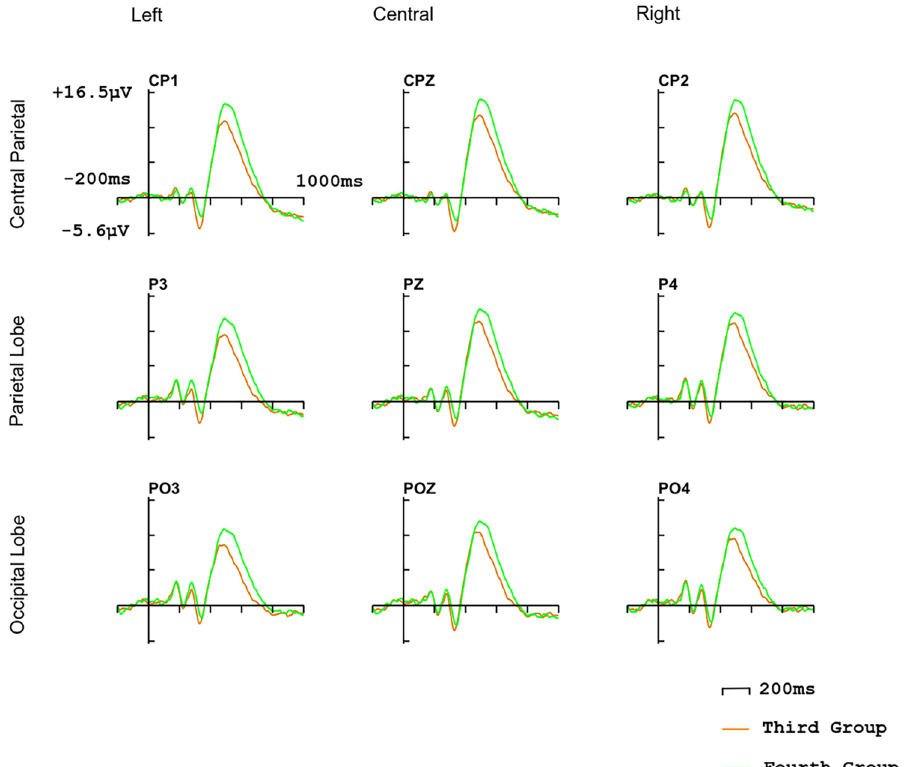
Fig. 6 ERP waves on CP1, CPz, CP2, P3, Pz, P4, PO3, POz, PO4 (electrodes that are used to analyze P3b component) of the second comparison group (third group and fourth group)